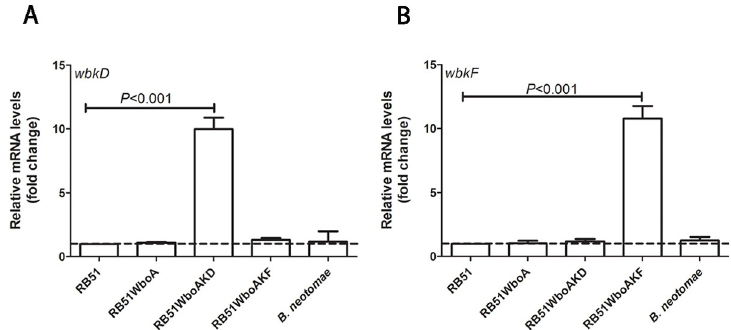
Fig 2. Transcript levels of wbkF in RB51WboAKF were nearly ten-fold higher than levels in RB51. RT-PCR detection of (A) wbkD and (B) wbkF mRNA in strains RB51, RB51WboA, RB51WboAKD, RB51WboAKF and B . neotomae . Graphs show the mean values of fold change for wbkD and wbkF transcript levels in the strains RB51WboA, RB51WboAKD, RB51WboAKF and B . neotomae relative to those of RB51, which were converted to 1. All the values are relative to those of internal control gene IF-1. Results are shown as mean ± standard deviation (n =